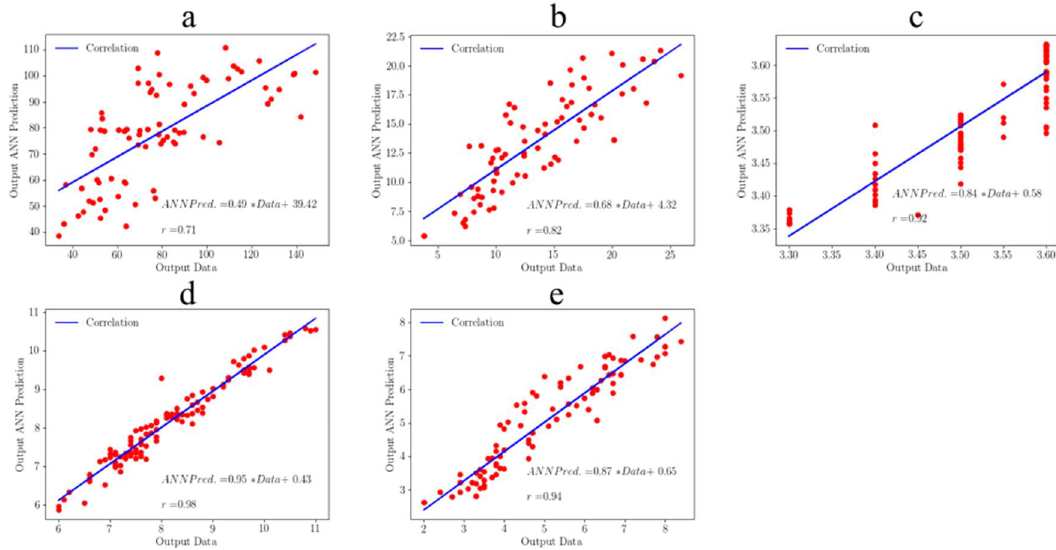
Figure 10. Correlation between output ANN prediction and output data for the training dataset ( a ) Phenols, ( b ) Flavonoids, ( c ) pH, ( d ) Viscosity, ( e ) Color.